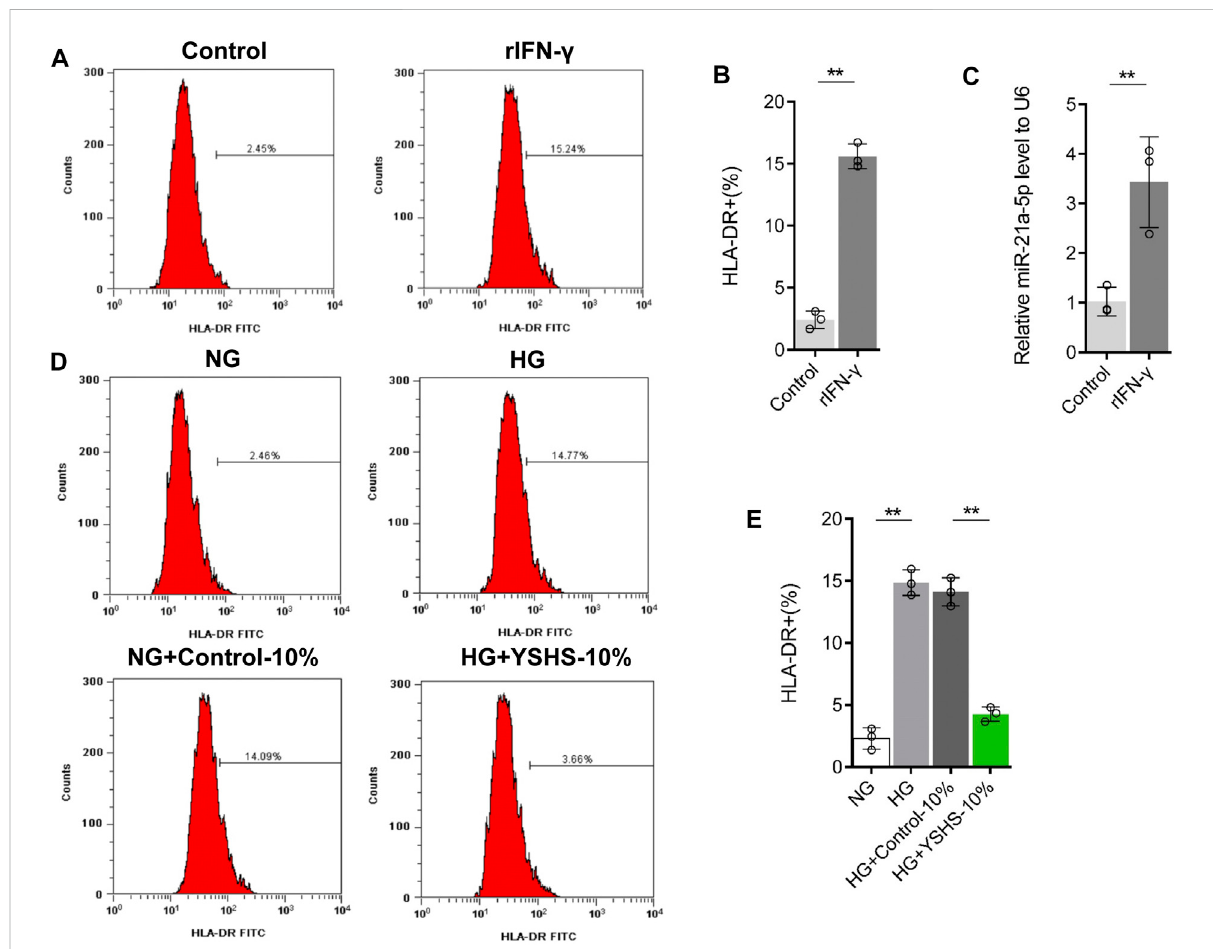
FIGURE 8 Effect of YSHS on the polarization of M1 macrophages. (A – B) Flow cytometry to detect the expression of HLA-DR in the macrophage treated with or without LPS (100 ng/ml) and recombinant IFN- γ (20 ng/ml) for 24 h. (C) Measurement of the miR-21a-5p content in macrophage-derived exosomes by qRT-PCR. (D – E) Flow cytometry to detect the expression of HLA-DR in macrophages treated with or without YSHS-serum in the presence of NG or HG. Data analysis adopts a Student ’ s t -test (B – C) or a one-way analysis of variance (E). LPS + rIFN- γ represents that macrophage RAW264.7 cells were treated with LPS (100 ng/ml) and recombinant IFN- γ (20 ng/ml) for 24 h, NG indicates that macrophage RAW264.7 cells were treated with normal glucose, HG represents that macrophage RAW264.7 cells were treated with high glucose, HG + control- serum indicates that macrophage RAW264.7 cells were treated with high glucose and 10% control serum, and HG + YSHS-serum represents that macrophage RAW264.7 cells were treated with high glucose and 10% YSHS-serum. SD indicated error bars. ** p <